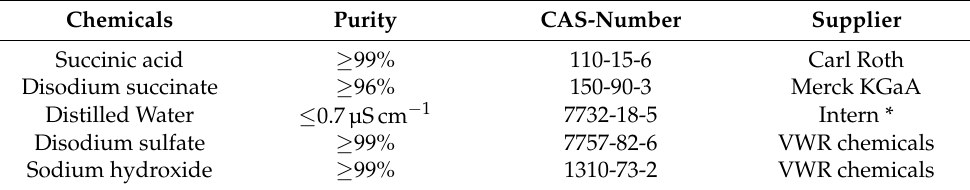
Table 1. Chemicals used for the solubility measurements and the crystallization experiments.